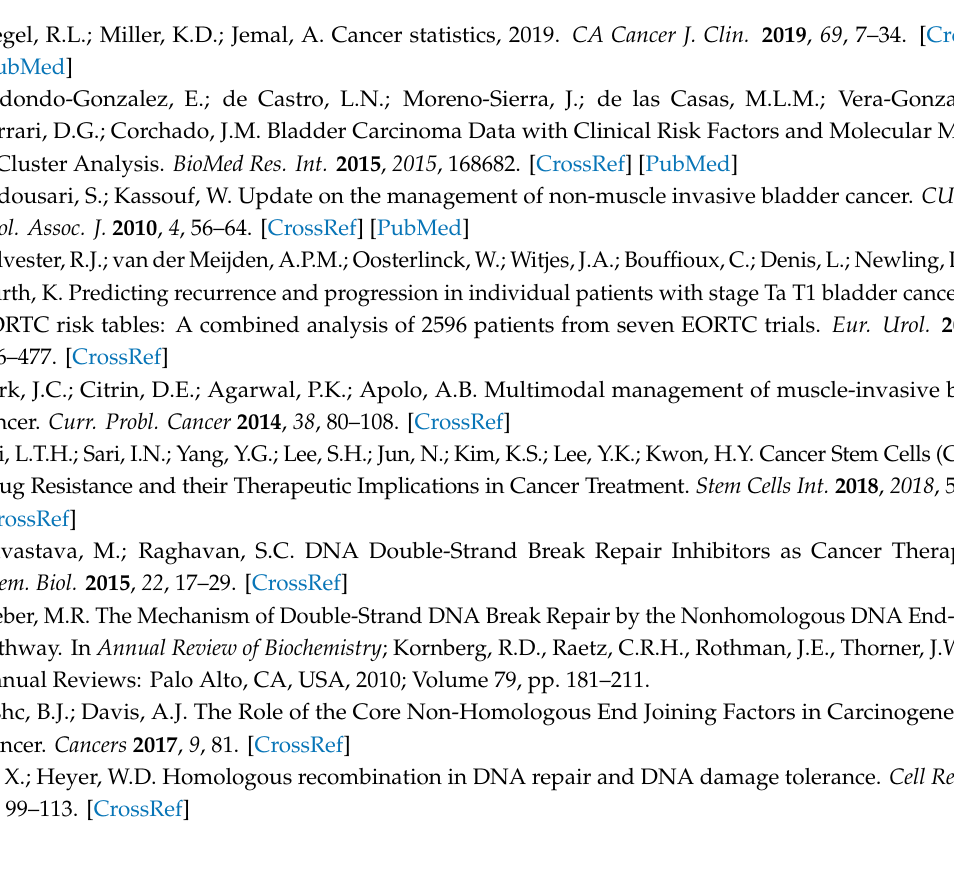
s1. Figure S1: Gene-gene network analysis showing E2F1 correlated genes. ( A ) Gene-gene interaction network associated with DNA repair genes. Each colored line represents functional and physical interactions in the literature, respectively. These networks were generated by GeneMANIA (http: // genemania.org) ( B ) GeneMANIA function analysis and significant enrichment of selected genes in bladder cancer patients. Figure S2: Schematic diagram of HR assay by DR-GFP. DR-GFP vector contains an I-SceI endonuclease site within the coding region, which abolishes GFP expression. Expression of I-SceI induces single DSBs. Figure S3: Schematic diagram of bioinformatics. RLEL, RAD54L low and E2F1 low; RLEH, RAD54L low and E2F1 high; RHEL, RAD54L high and E2F1 low; RHEH, RAD54L high and E2F1 high. Figure S4: Hierarchical clustering analysis of gene expression data from GSE13507 for patients with NMIBC. ( A ) Heat map of RAD54L correlated 1027 genes in 102 NMIBC patients. Two subtypes of patients were revealed from unsupervised clustering analysis using RAD54L correlated 1027 genes. ( B ) Depending on the expression of E2F1, two subtypes are redefined into four 4 new subtypes. Figure S5: E2F1 and RAD54L expression levels are not correlated with recurrence in BLC patients. ( A ) IHC staining with anti-E2F1, RAD54L antibody was performed for non-recurrent BLC tumor tissues and recurrent BLC tumor tissues. Photographs were taken at a magnification of 400 × . ( B ) Recurrence-free survival in NMIBC patients (GSE13507, n = 102, p = 0.05 by log-rank test, left panel). Recurrence-free survival in NMIBC patients (GSE13507, n = 102, p = 0.18 by log-rank test, right panel). RLEL, RAD54L low and E2F1 low; RLEH, RAD54L low and E2F1 high; RHEL, RAD54L high and E2F1 low; RHEH, RAD54L high and E2F1 high. Table S1: qRT-PCR and plasmid construction primer